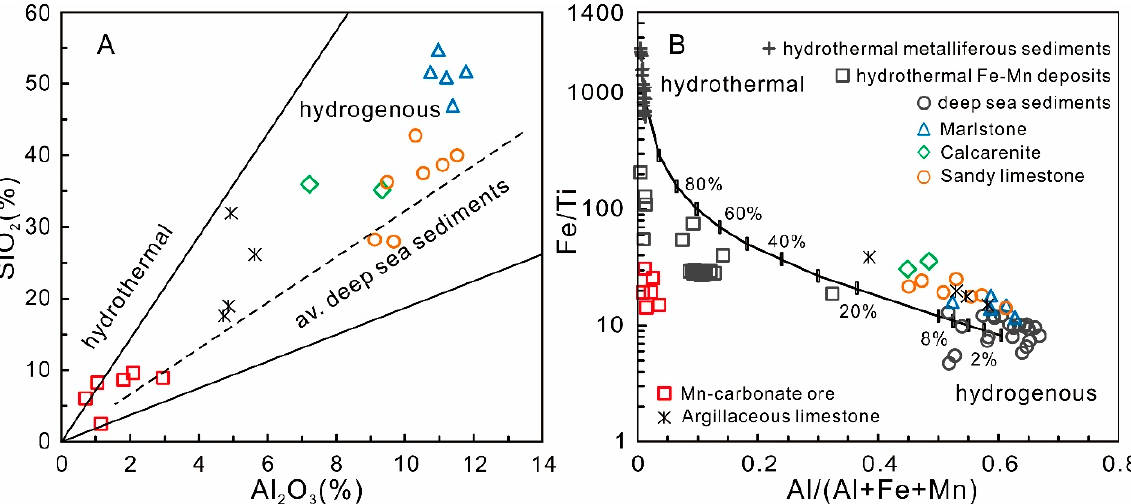
Figure 9. Discriminant plots of sediments with hydrothermal and hydrogenous origins. ( A ) SiO 2 vs. Al 2 O 3 [115]. Data of average deep-sea sediments are from [117]. ( B ) Fe/Ti vs. Al/(Al + Fe + Mn), and the line shows hydrothermal composition percentages [116]. Data of hydrothermal Fe-Mn deposits are from [76,77].